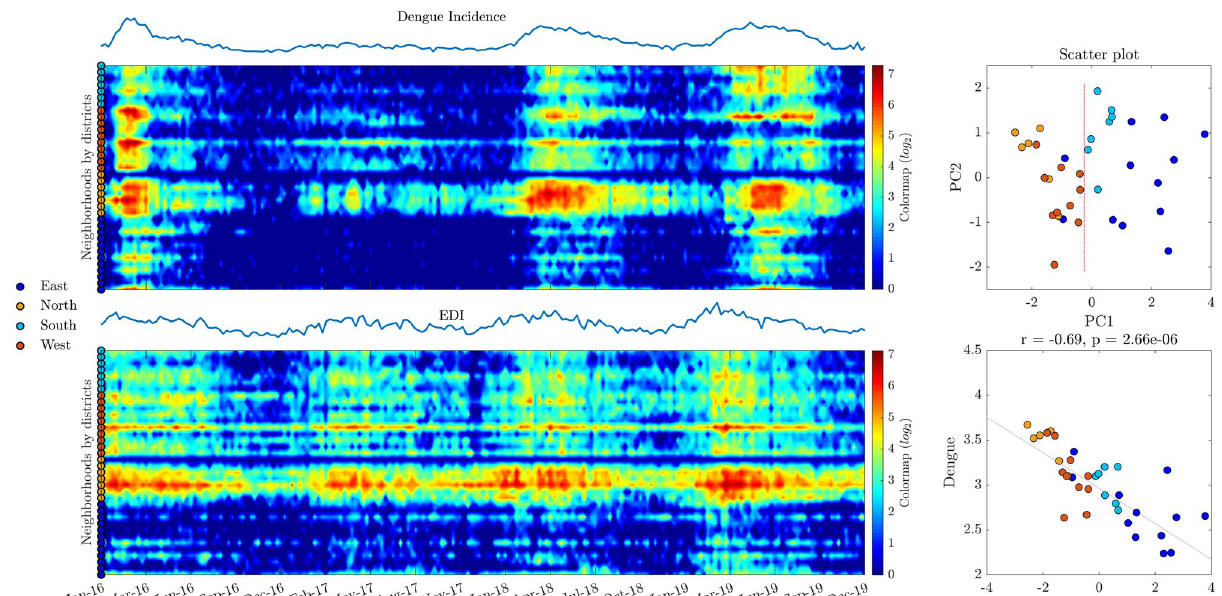
Figure 1. Evolution of dengue incidence and EDI* and the association of accumulated dengue incidence by neighborhoods and socioeconomic variables. ( a ) Representation of heat maps for EDI and dengue incidence, neighborhoods grouped by districts. ( b ) Upper panel: scatter plot of PC1 vs. PC2 for PCA of socioeconomic variables; bottom panel: PC1 vs. accumulated dengue incidence (log2 transformed) by neighborhoods. (*EDI for each neighborhood was weighted by the respective population. The neighborhood with the higher population was multiplied by 1, and the remainder was multiplied by a proportional